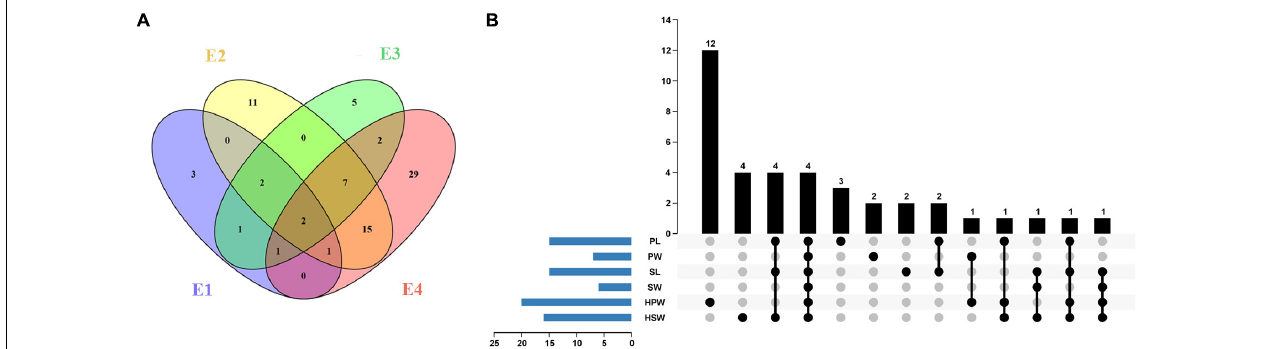
FIGURE 3 | The profile of the associated loci for the six yield-related traits of the Chinese peanut mini-core collection under four different environments. (A) The Venn diagram of associated loci for six traits under four environments (E1–E4). (B) The statistical column diagram of the associations of the six yield-related traits and their interactive upset plot. E1, Nanchong in 2015; E2, Wuhan in 2015; E3, Nanchong in 2016; E4, Wuhan in 2016; PL, pod length; PW, pod width; SL, seed length; SW, seed width; HPW, hundred-pod weight; HSW, hundred-seed weight.